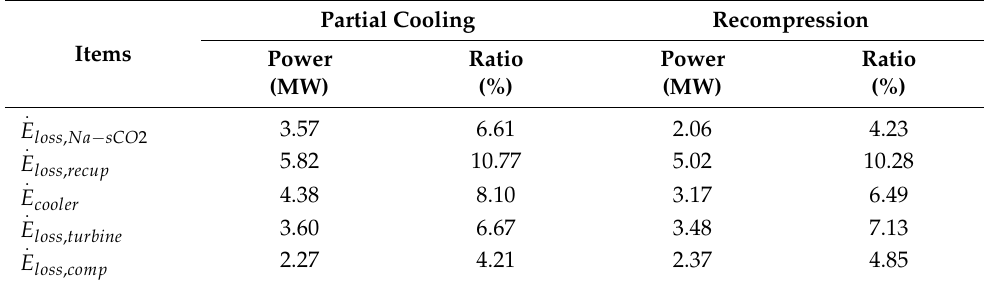
Table 5. Comparisons of exergy losses between the partial-cooling and recompression cycles. Partial Items